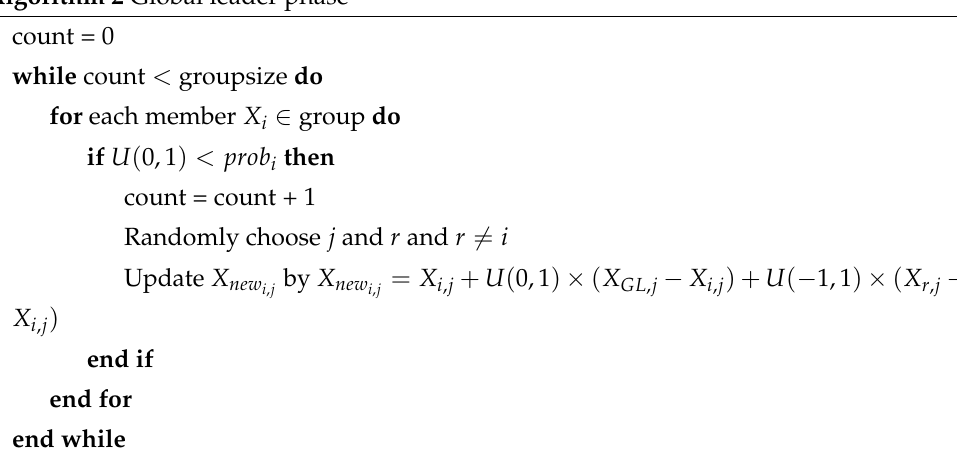
Algorithm 2 Global leader